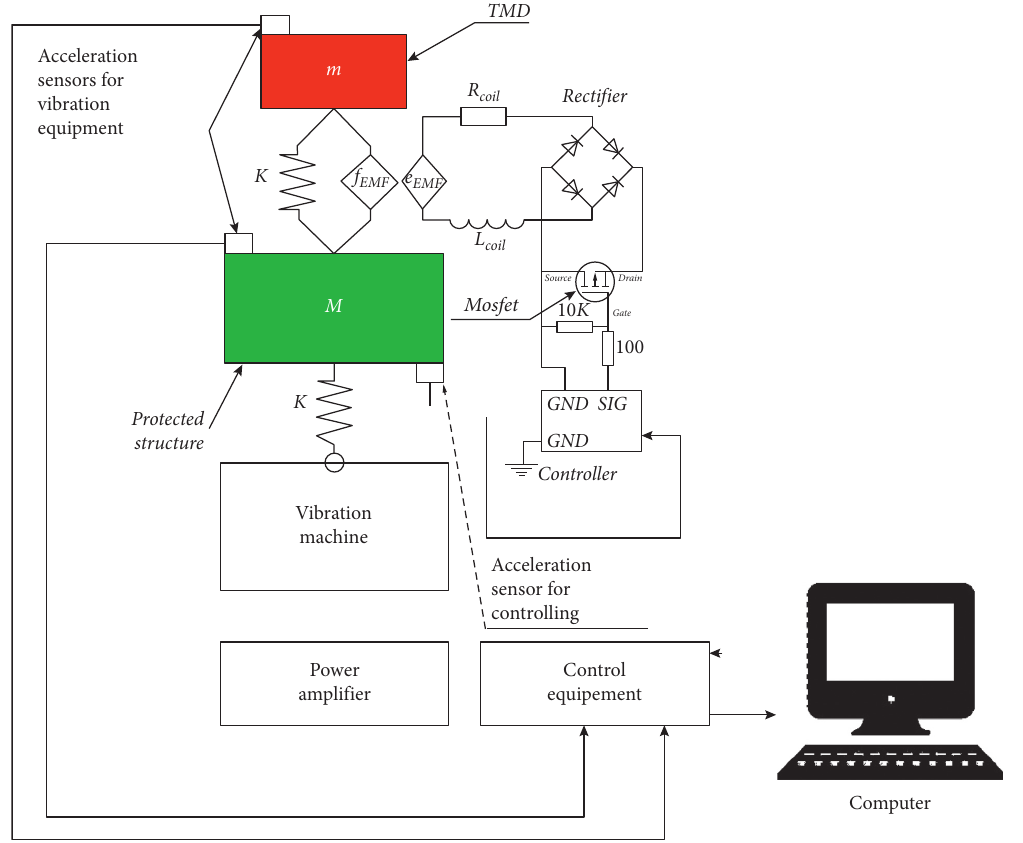
Figure 7: Experimental schematic layout of the TMD.